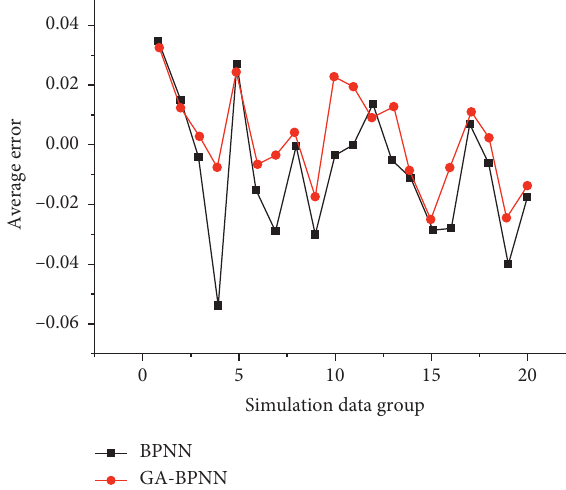
Figure 3: Comparison on average output error of the standard BPNN and GA-BPNN.